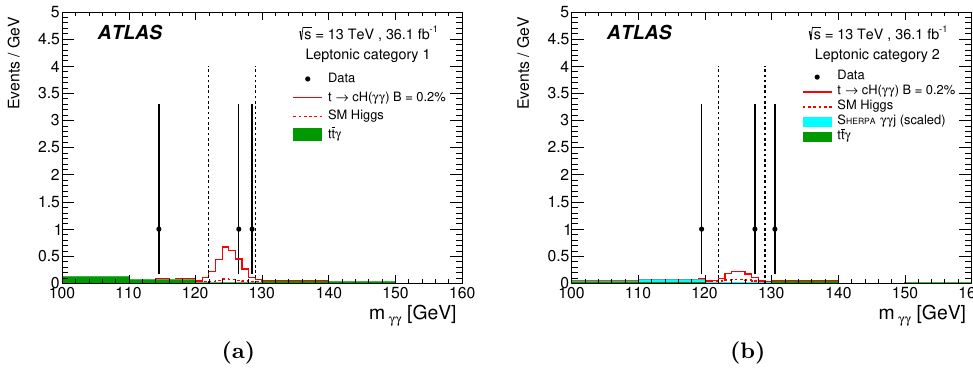
Figure 4. Distributions of the diphoton invariant mass for (a) category 1 and (b) category 2 of the leptonic analysis. The t (cid:22) t(cid:13) distribution is normalised to the data’s integrated luminosity using the theoretical cross section. The Sherpa S (cid:13)(cid:13)j contribution is shown for category 2, where its contribution is signi(cid:12)cant (see text). The SM Higgs boson production and an additional FCNC signal normalised assuming B = 0.2% are shown stacked over the backgrounds. The vertical dotted lines indicate the signal region (see